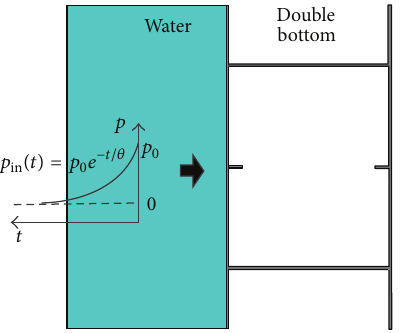
(3) wet for the panel with girder (I-shaped) with the parameter 𝛾 (3) for the panel with girder (I-shaped). max to the normalized parameter